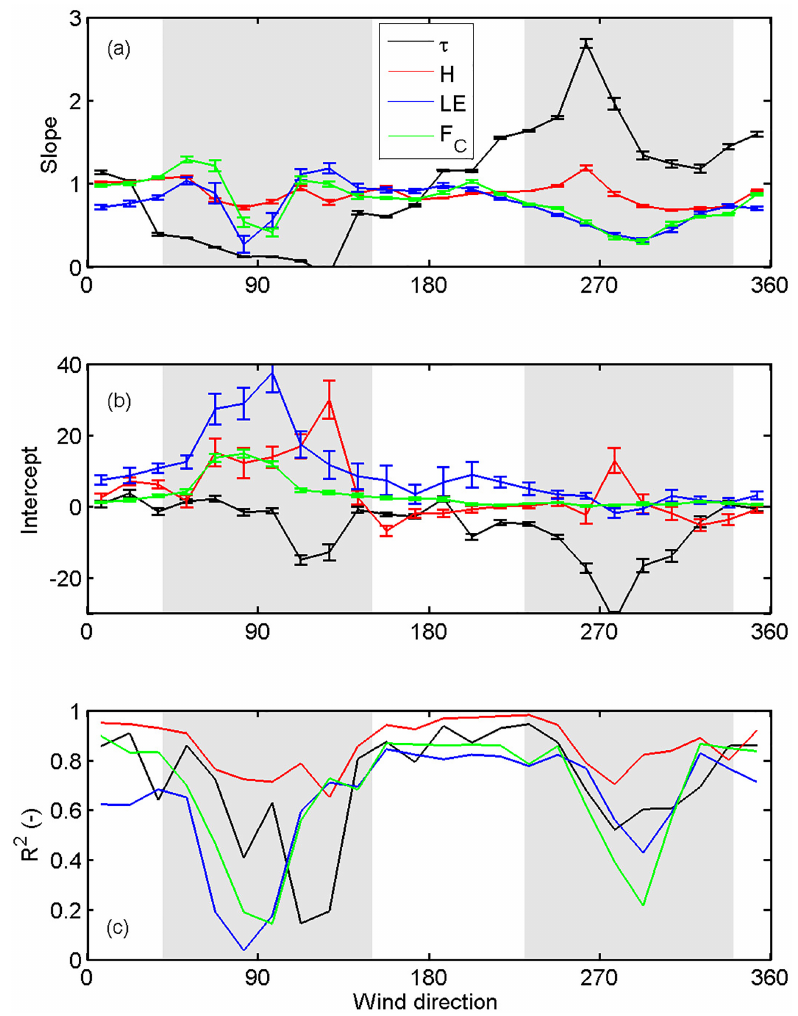
Figure 5. Wind direction dependence of the (a) slope, (b) intercept (kgm − 2 m − 1 , Wm − 2 , µmolm − 2 s − 1 ) and (c) squared coefficient of determination ( R 2 ) of the linear least square fit of momentum ( τ ), sensible ( H ) and latent heat (LE), and CO 2 ( F C ) fluxes between the two EC systems (EC2 = slope · EC1 + intercept) during July 2013 until September 2015. The neglected wind directions (40–150 ◦ for EC1 and 230–340 ◦ for EC2) are marked with grey